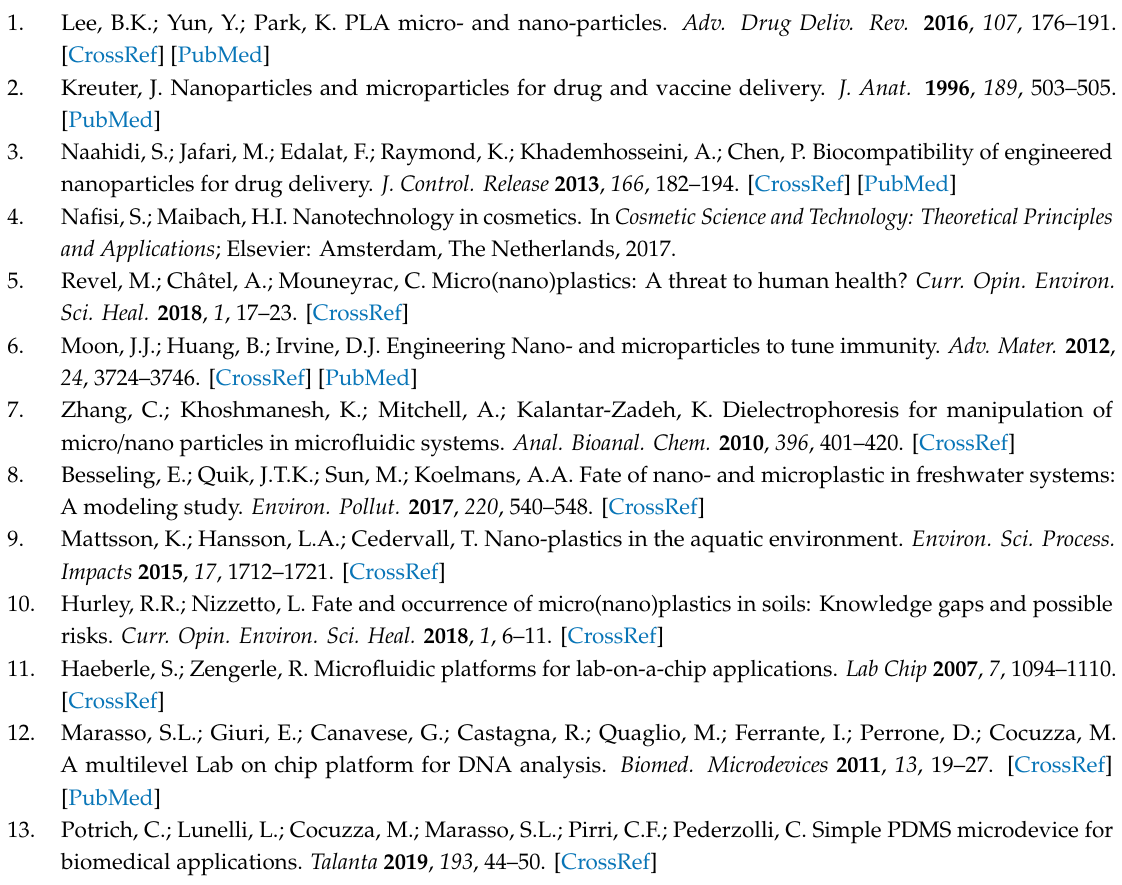
Figure S1: Size measurement of 4 µ m MPs by Dynamic Light Scattering; Figure S2: Size measurement of 500 nm NPs by Dynamic Light Scattering; Figure S3: Size measurement of EXs by Dynamic Light Scattering; Figure S4: 4 µ m MPs calibration curve: trendline equation y = 2 × 10 − 8 x + 0.005; Figure S5: The 500 nm NPs calibration curve: trendline equation y = 7 × 10 − 10 x − 0.001; Figure S6: Absorbance spectrum of 500 nm carboxylated NPs: excitation wavelength = 297 nm; Figure S7: Size measurement of 4 µ m MPs by Dynamic Light Scattering at outlet#3 when 0 V were applied at the electrodes; Figure S8: Size measurement of 4 µ m MPs by Dynamic Light Scattering at outlet#1 when 30 V were applied at the electrodes; Figure S9: Size measurement of 4 µ m MPs by Dynamic Light Scattering at outlet#1 when 40 V where applied at the electrodes; Figure S10: Number of M / NPs collected at outlet#2 when ∆ V = 0, 30, 35, 40 and 55 V were applied at the electrode; Figure S11: Number of M / NPs collected at outlet#3 when ∆ V = 0, 30, 35, 40 and 55 V were applied at the electrode; Table S1: DLS particles